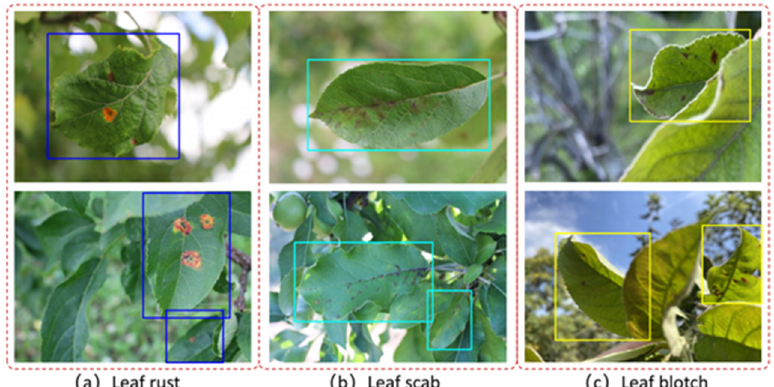
Figure 1. Examples of three different apple leaf diseases.